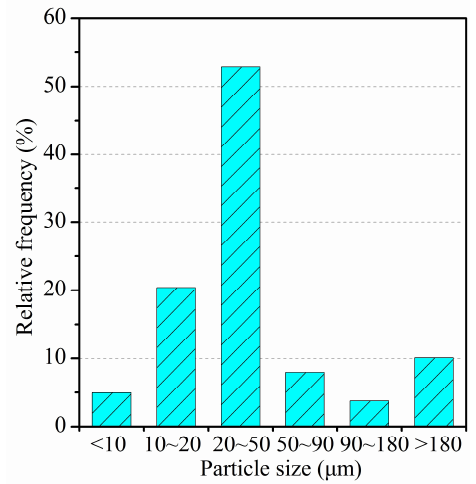
Figure 5 . Shapes of the sampled dust in a metal mine .